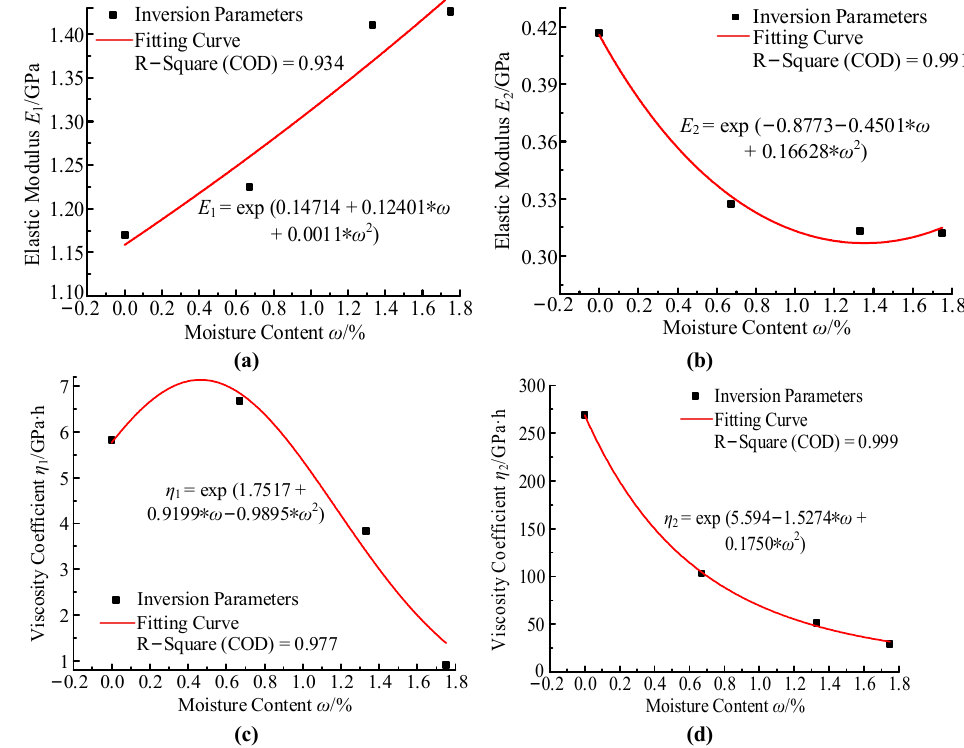
Figure 3. The fitting relationship curve of each parameter in the model and moisture content: ( a ) Fitting curve between elastic modulus E 1 and moisture content; ( b ) fitting curve between elastic modulus E 2 and moisture content; ( c ) fitting curve between viscosity coefficient η 1 and moisture content; ( d ) fitting curve between viscosity coefficient η 2 and moisture content.